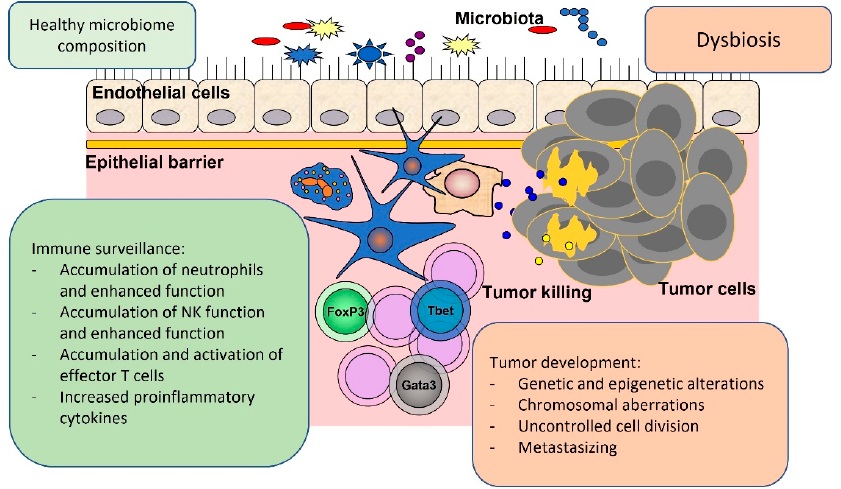
Figure 1. Immune surveillance and tumor development are connected with the state of health of the microbiome composition or